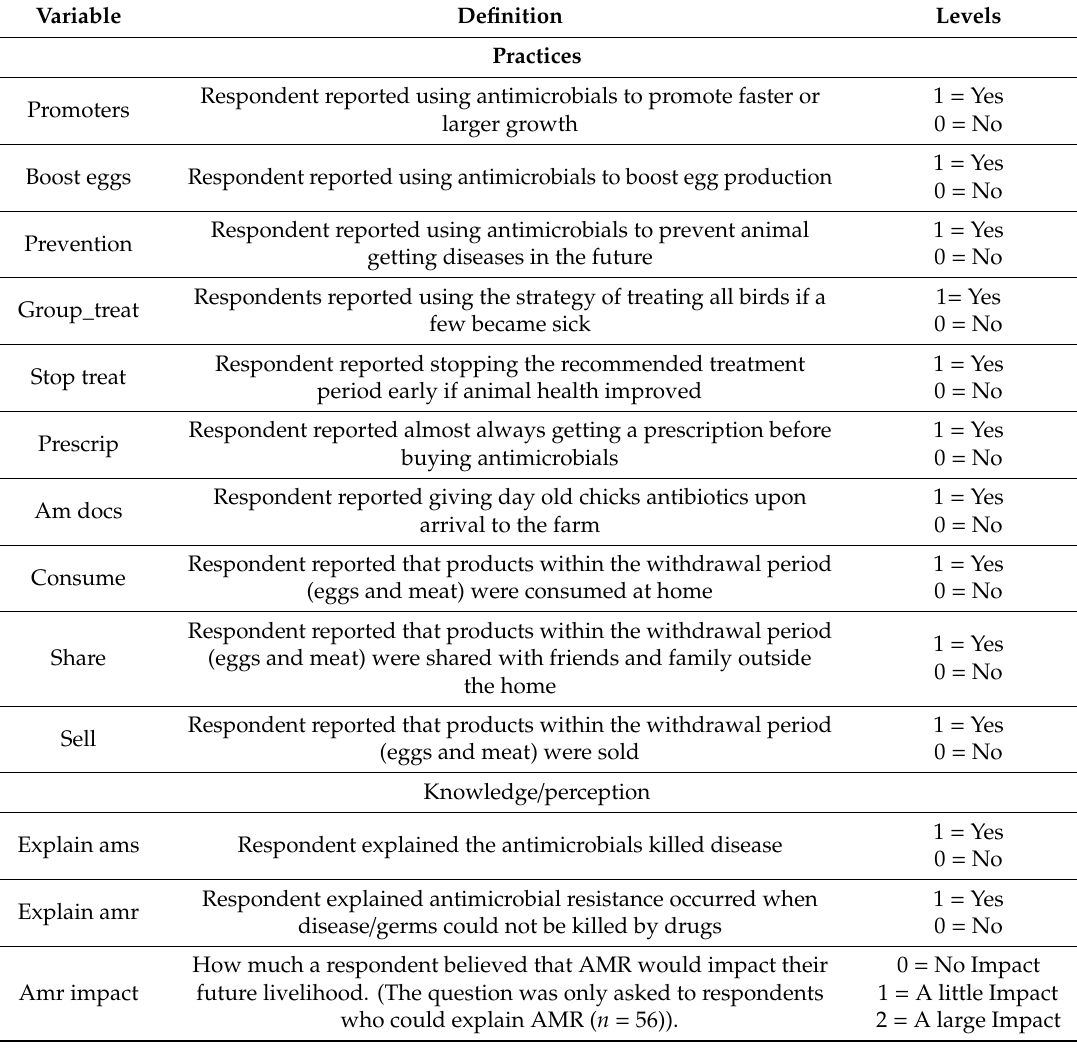
Table 2. Knowledge, attitudes, and practices variables included in the Fisher exact test included in models. For health-seeking variables included in the model, see Table 1) AM stands for